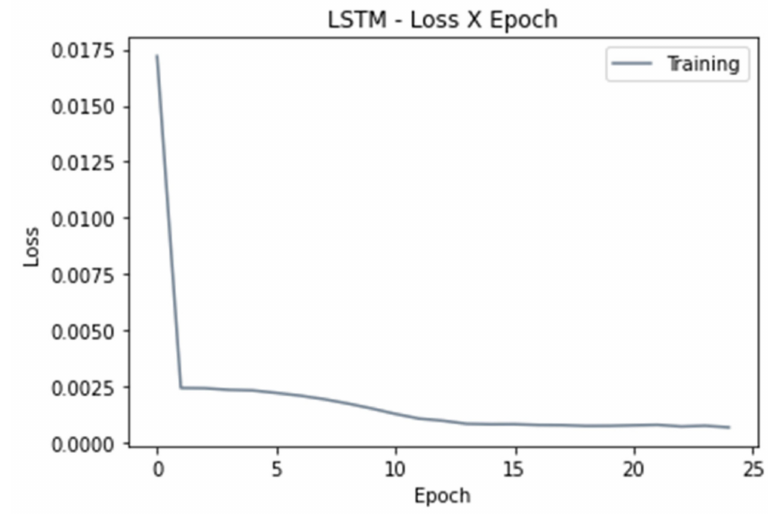
Figure 13. Loss versus number of epoch.